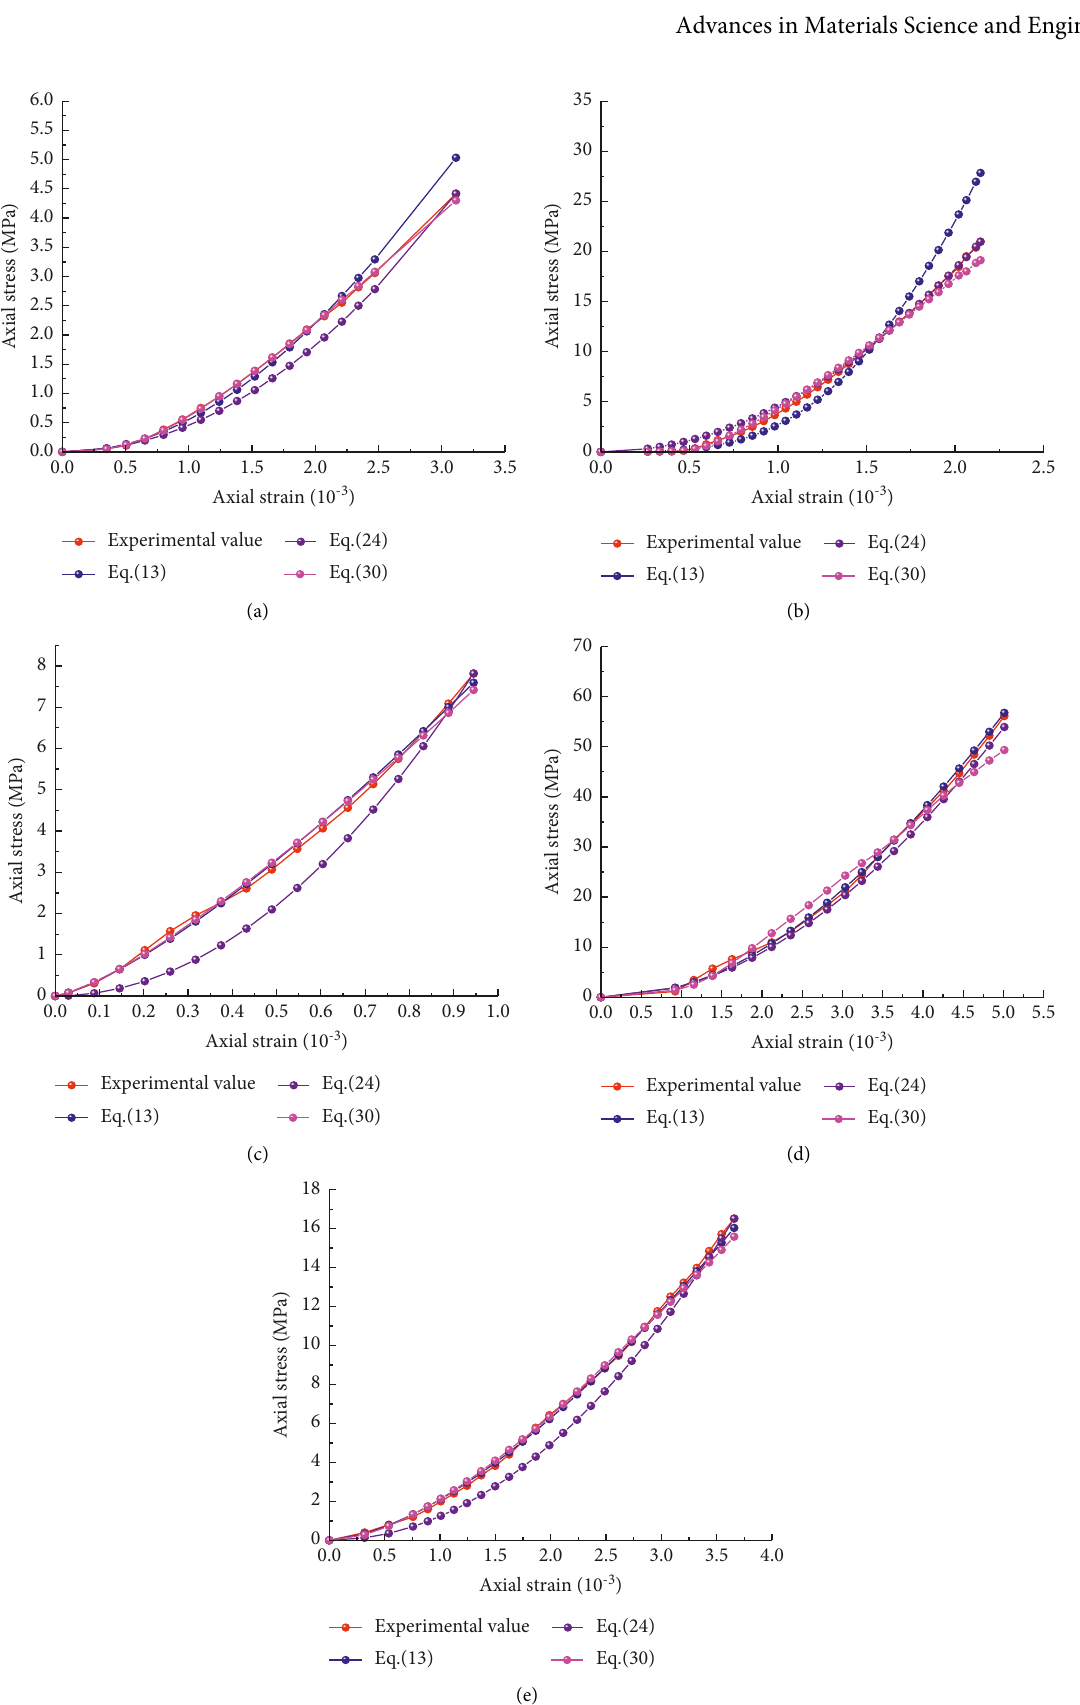
Figure 6: Comparison of the test data and the fitting curves based on different theories. (a) Coal. (b) Granite. (c) Marble. (d) Shale. (e)